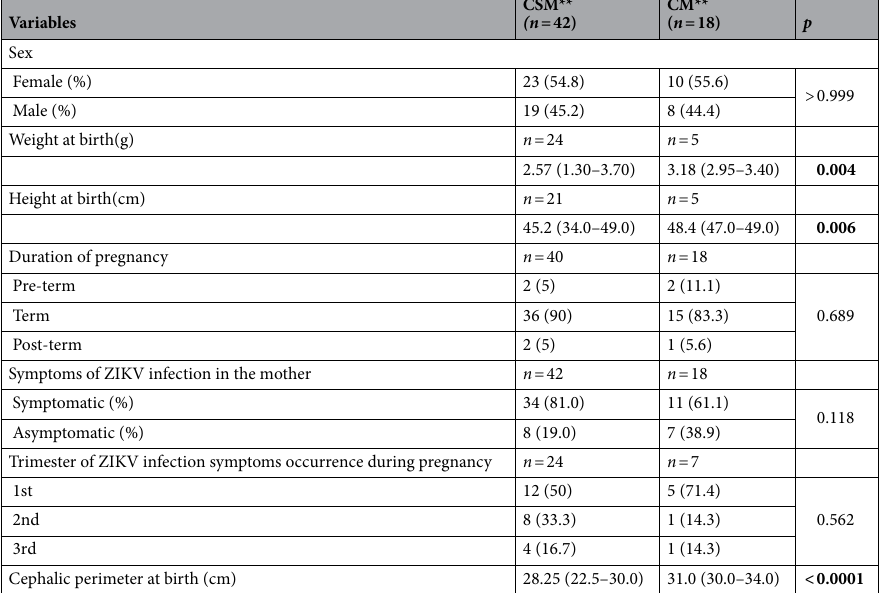
Table 2. Clinical-epidemiological variables in cases of CZS stratified by severity of microcephaly. CSM, children with severe microcephaly due congenital Zika syndrome; CM, children with microcephaly due congenital Zika syndrome; The information about the trimester of ZIKV infection during pregnancy was not available or mothers responded that they did not remember; Pre-term: less than 259 days (37 weeks), term: 259–293 days (37–41 weeks), post-term: 294 days (42 weeks) or more; Quantitative variables were compared between groups using Student’s t test or Mann–Whitney U test and are presented as mean minimum and maximum value; Categorical variables were compared between groups using Chi-squared test or Fisher’s exact test. Bold indicates statistically significant. **Individuals in this category may present other malformations in addition to